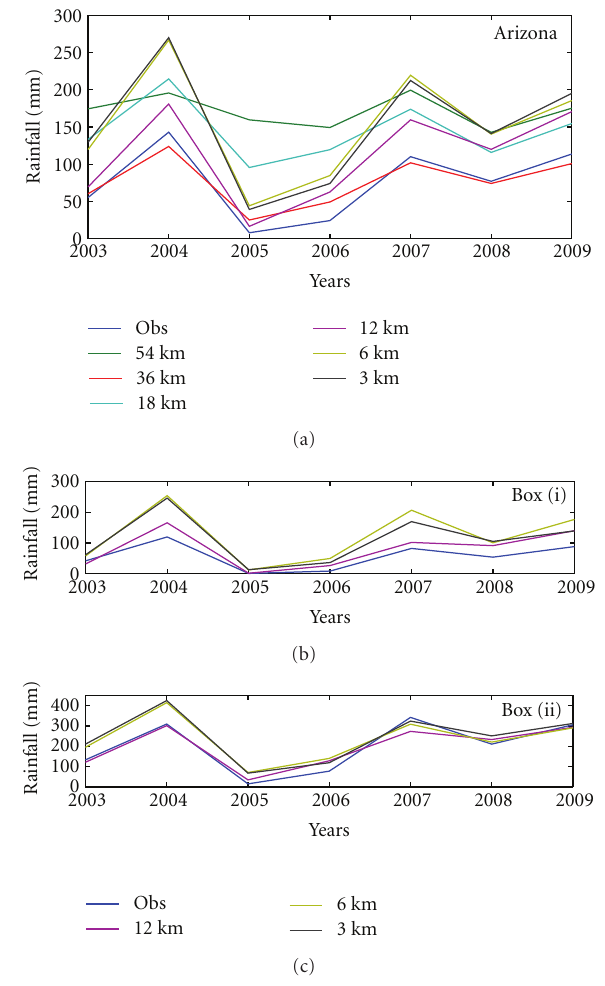
Figure 6: Comparisons of the simulated winter seasonal mean rainfall with observation. Shown are the averages over (a) the entire innermost model domain that covers the State of Arizona, (b) box (i), and (c) box (ii) (as marked in Figure 2(a)). The observation from PRISM data is in dark blue. The cases for the simulations are labeled in the legends. See text for